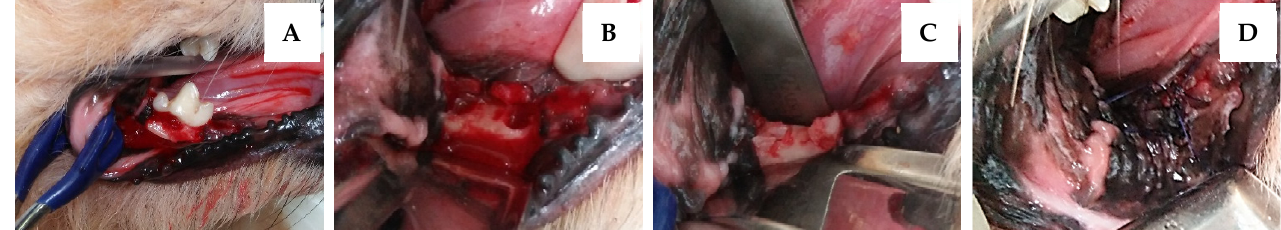
Figure 1. Steps for nanohydroxyapatite-based hydrogel (HAP hydrogel) placement in alveolar socket. ( A ) An open dental extraction technique was performed on the unilateral mandibular first molar tooth (309 or 409). ( B ) Post-extraction sockets of the mesial root and distal root were noted as tested sockets for post-extraction preservation. ( C ) Each post-extraction